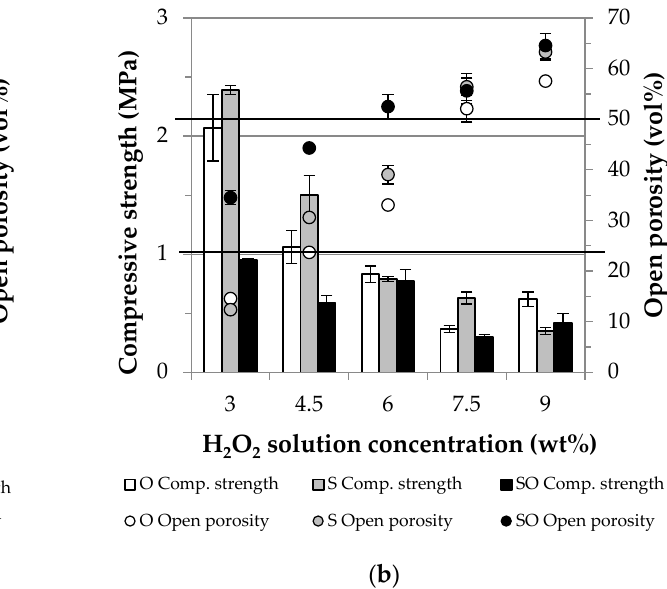
Figure 1. Effect of the H 2 O 2 solution concentration in the range of ( a ) 0–30 wt% and ( b ) 3–9 wt% on the compressive strength and open porosity of GP foams using different stabilising agents (Horizontal lines indicate boundary conditions in the case of the experimental job).